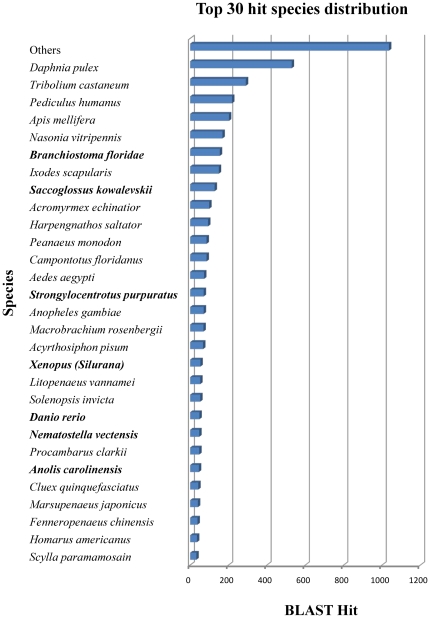
Top 30 hit species distribution based on BLASTx.E value cut-off is 1e–5 and top 30 hit species distribution of gene annotations showing high homology to the Arthropoda (Insecta and Crustacea) phylum with known genome sequences. Only contig sequences were used. Bold text indicates non-Arthropod homology.